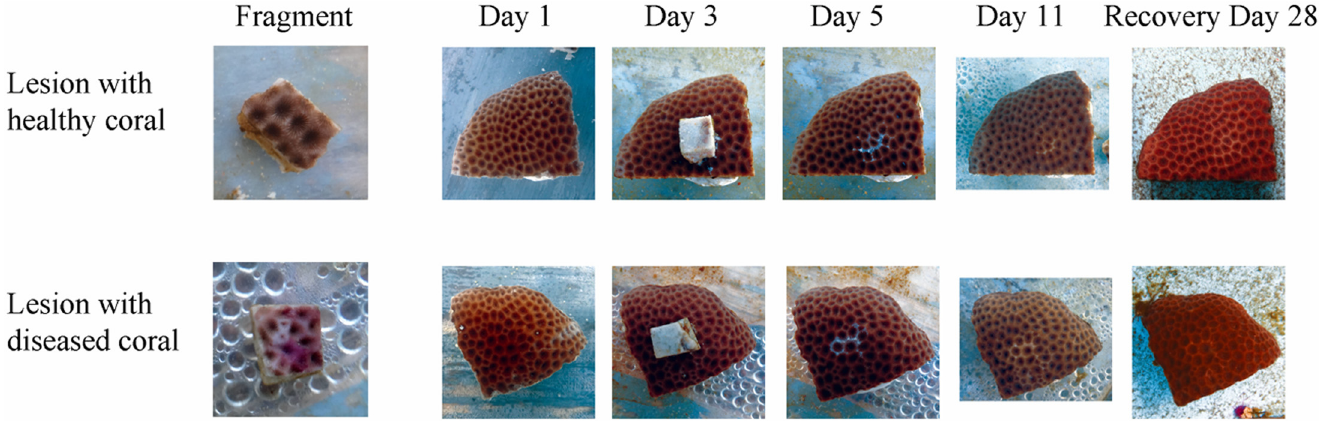
Fig 4. Time-series images of two healthy-coral colonies (~16 cm 2 ) of Siderastrea siderea in a direct-contact transmission experiment. The first column of images is a close-up of the fragments (~1 cm 2 ) that were placed in direct contact with the coral colonies. The first row of images show a healthy- coral colony (~16 cm 2 ) in direct contact with a healthy fragment (~1 cm 2 ) (control). The second row of images show a healthy-coral colony in direct contact with a fragment with dark spot lesions (~1 cm 2 ) (experimental). Note that Day 1 images were taken prior to the addition of the direct-contact coral fragment. Note also the direct-contact lesion scars on S . siderea on Day